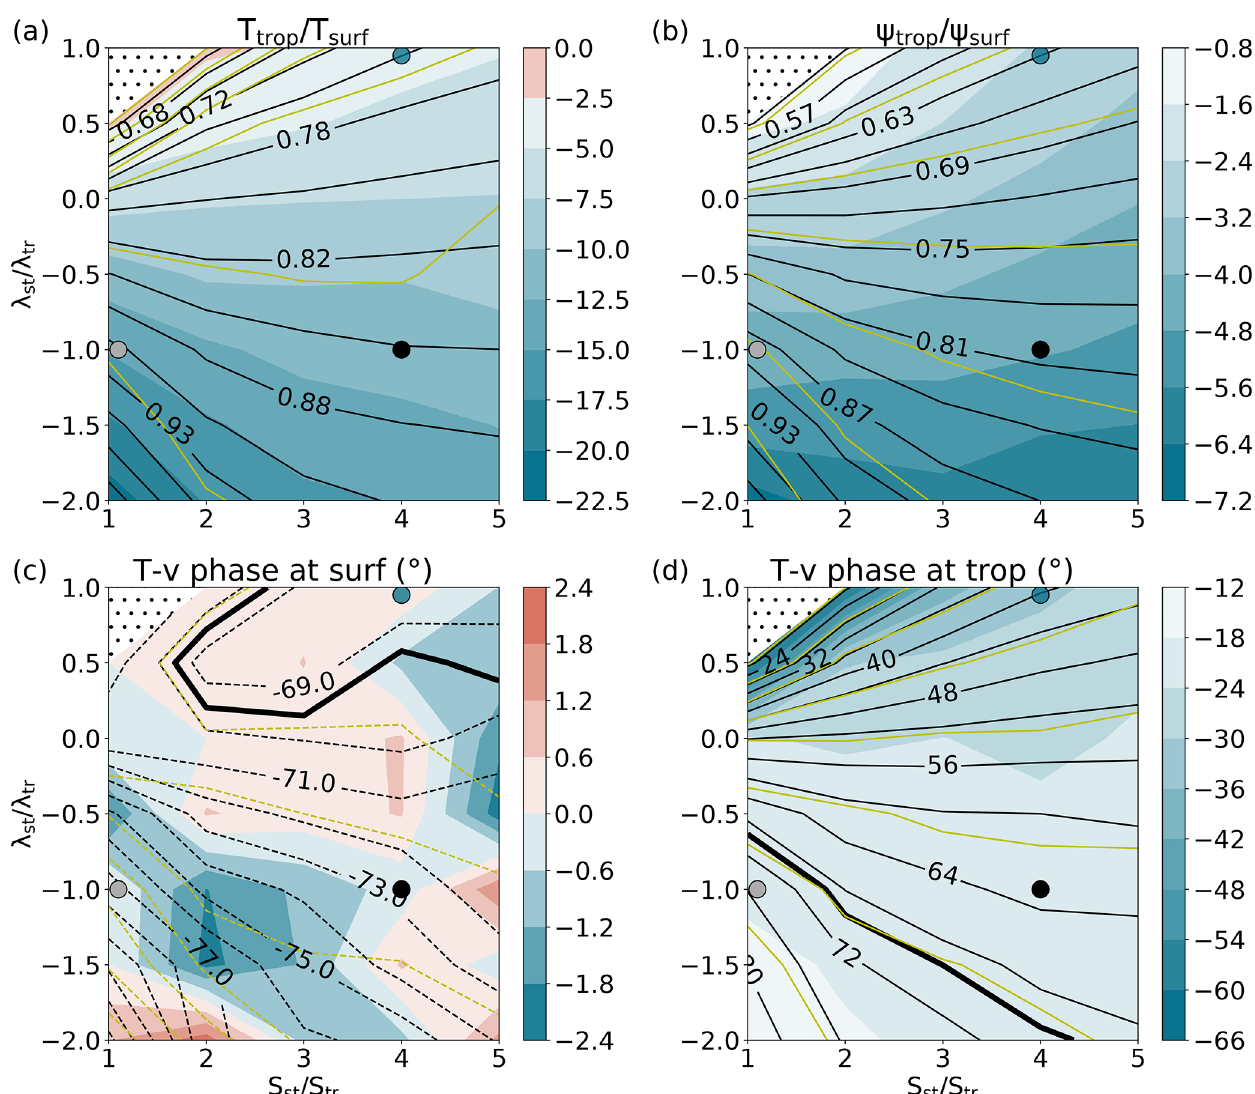
Figure 5. Same as Fig. 4 but for − ∂ψ/∂p and ψ at the tropopause relative to surface and the phase shift of T and v at the surface and just below the